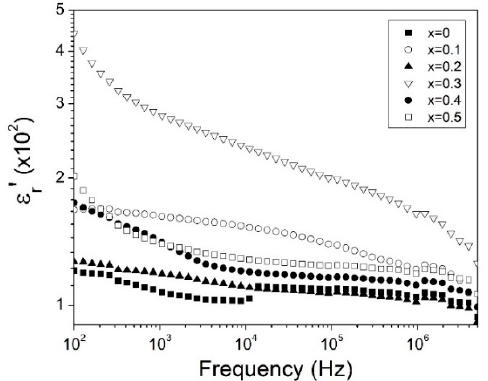
Figure 5. The real part of the complex relative permittivity ( ε r ') at room temperature as a function of frequency of Bi 3+ doped YFeO 3 for 0 ≤ x ≤ 0.5, ∆ x = 0.1, of pressed and sintered samples at 700 ° C.